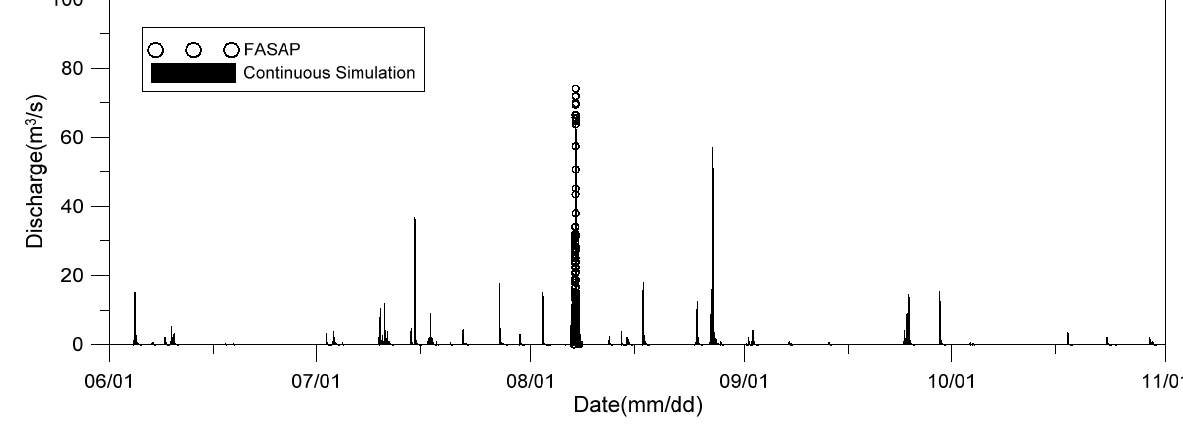
Figure 14. Flow hydrograph from FASAP and continuous simulation in